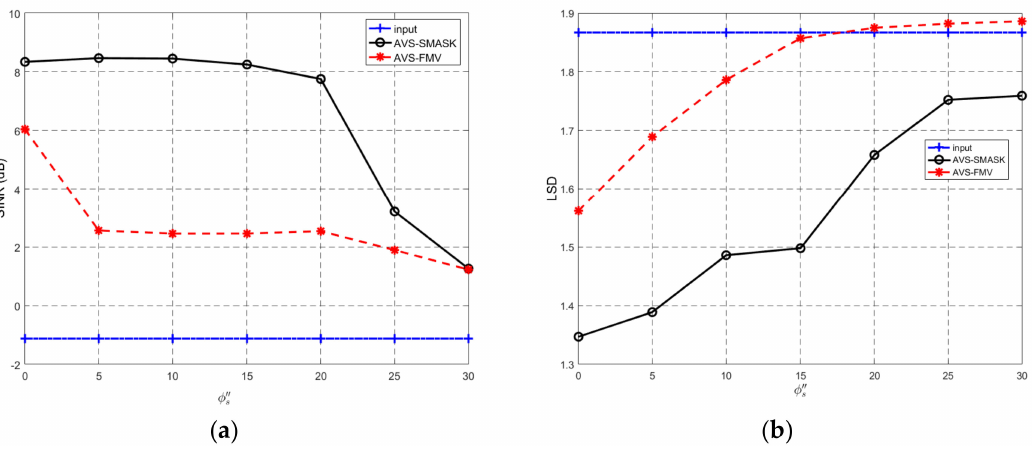
Figure 11. (Experiment 5) The performance versus the φ s mismatch φ s ” . ( a ) PESQ results and ( b ) LSD